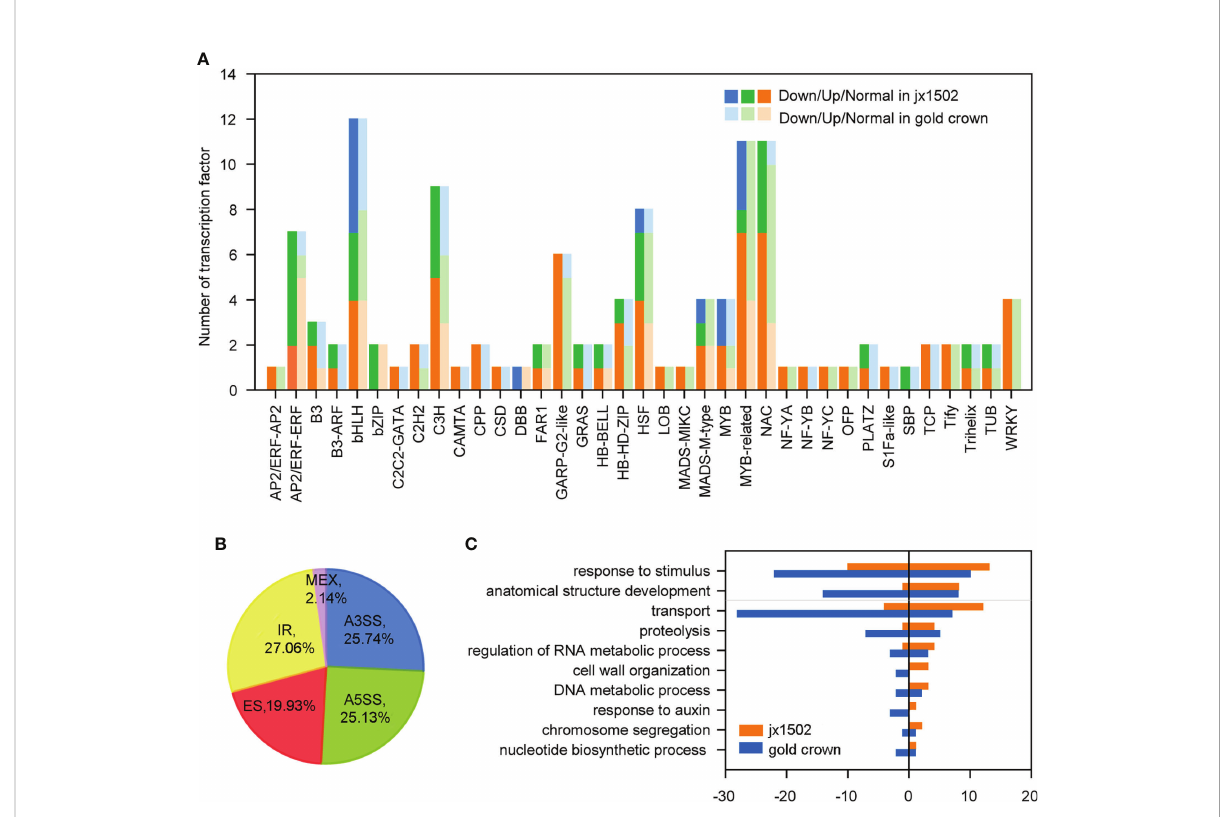
FIGURE 3 (A) Number and expression pro fi le of TFs identi fi ed in ‘ jx1502 ’ and ‘ gold crown ’ under salt stress. (B) Distribution of fi ve types AS events in 12 libraries. (C) GO annotation of biological process for DAS-DEGs under salt stress. The positive and negative numbers represent the numbers of upregulated and downregulated DAS-DEGs under salt stress,